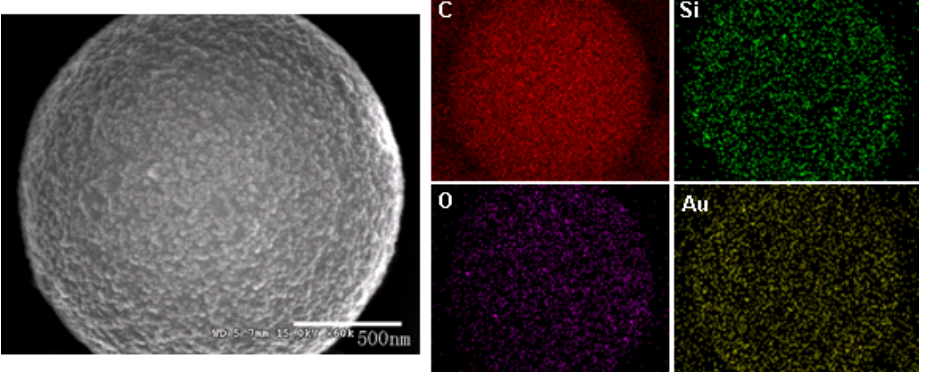
Figure 4. The SEM image and energy dispersive X-ray spectrometry analysis element mapping of a polystyrene-silica particle prepared using KPS as the initiator. Red, green, purple and gold represent carbon, silicon, oxygen, and gold elements,